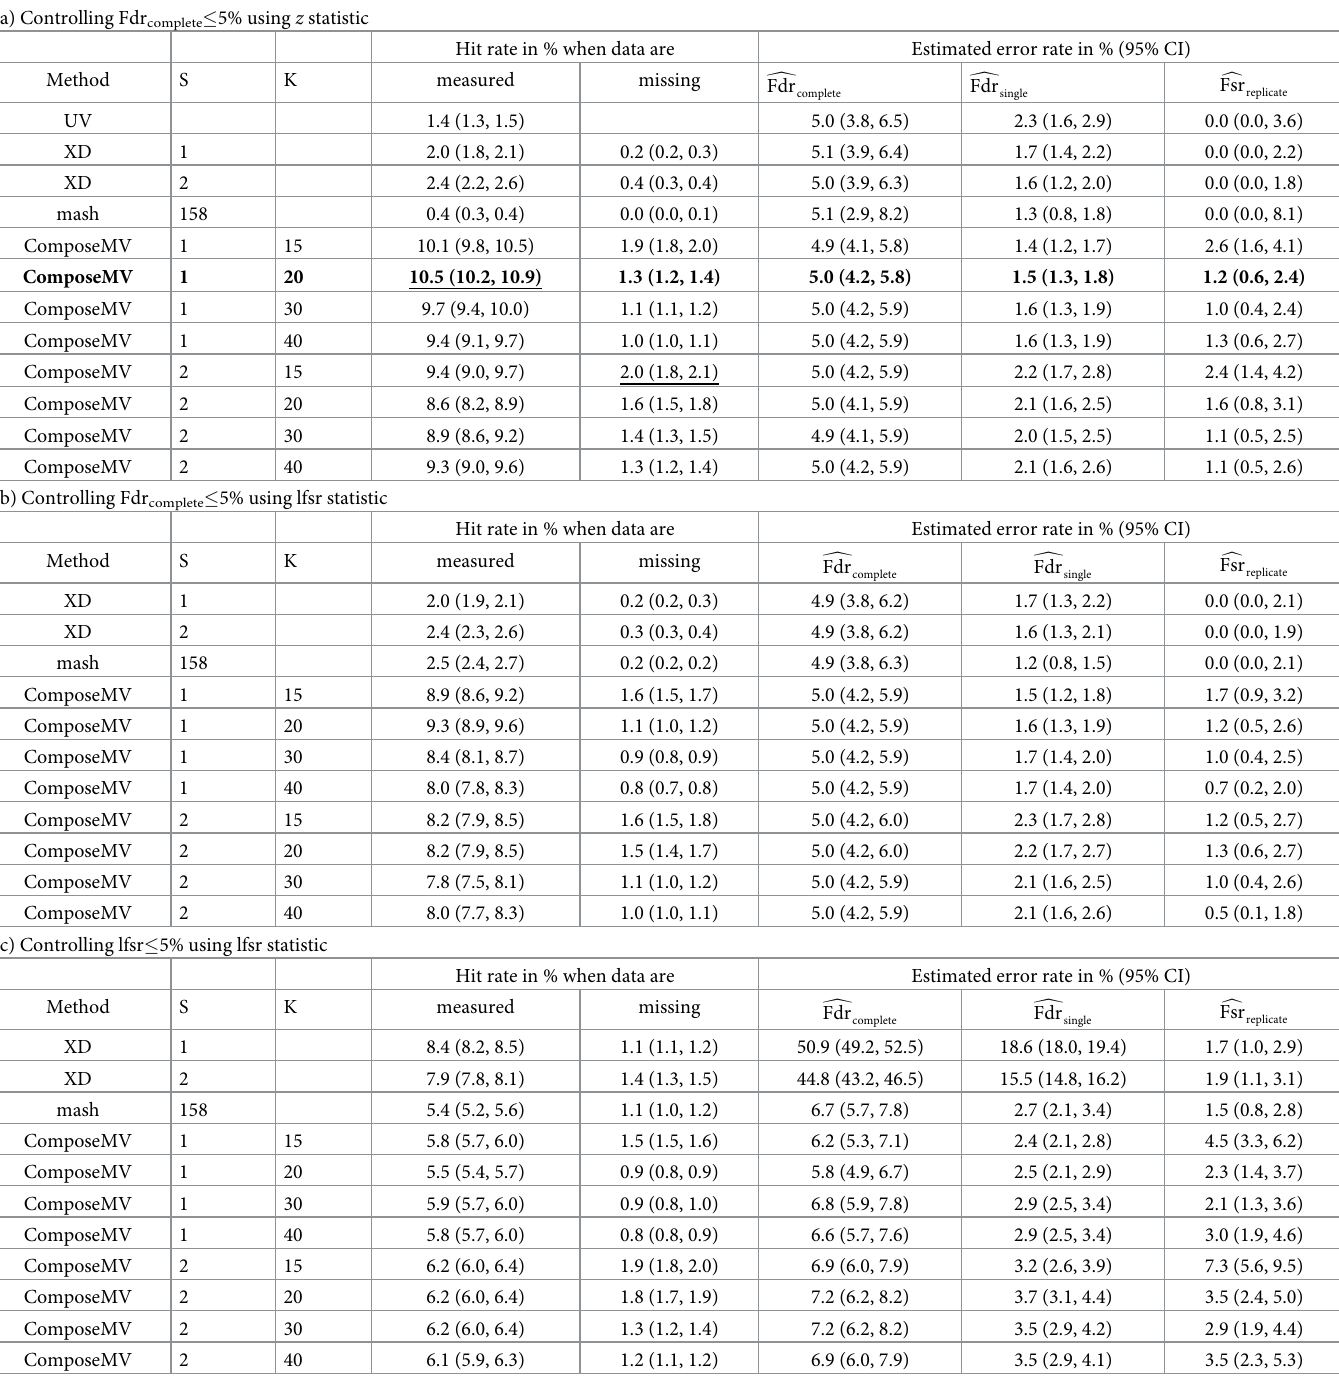
Table 7. Hit rates and error rates compared across models. The row showing the model and error rate control used in the main analyses in the paper, M highlighted in bold. The highest hit rates are underlined. (a) Controlling Fdr complete � 5% using z